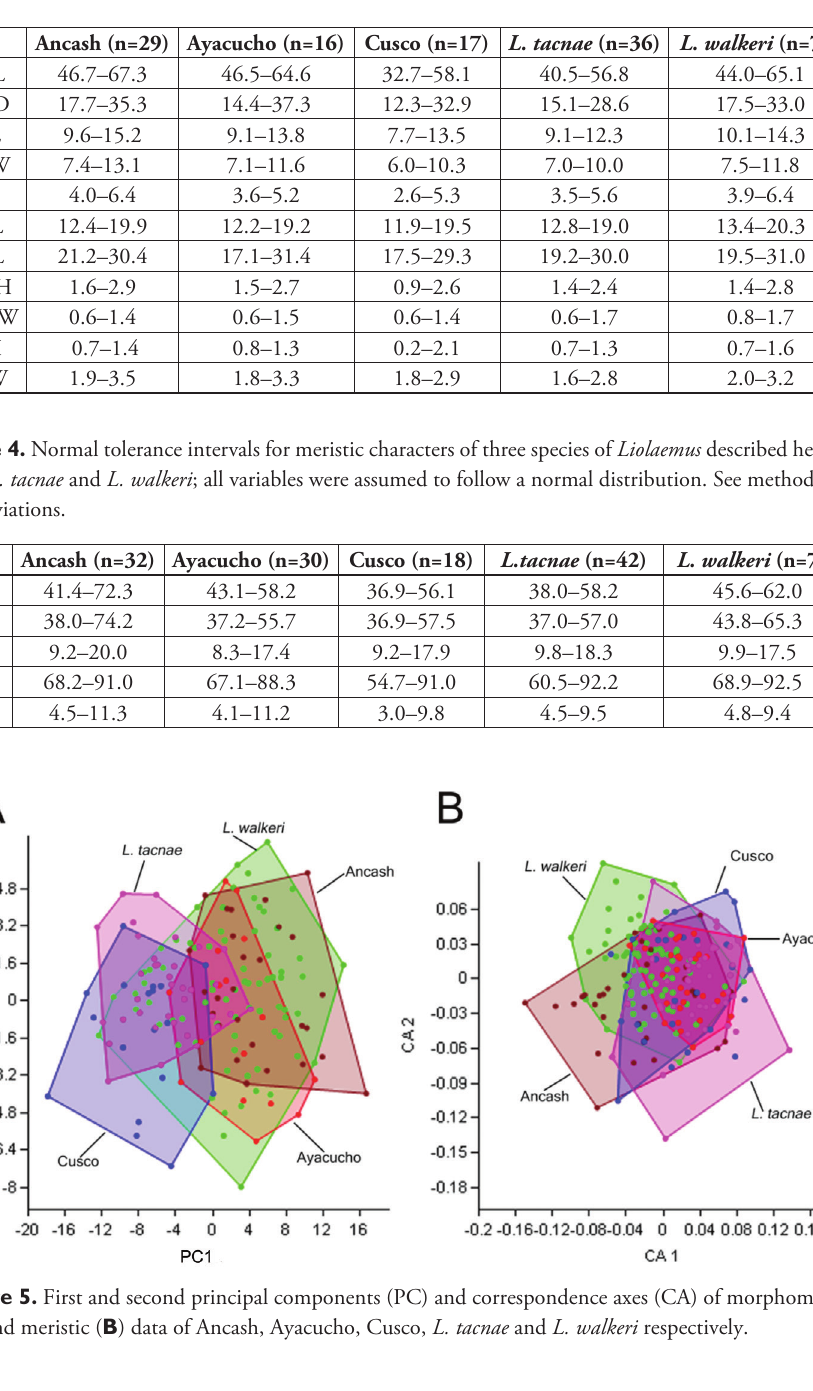
table 3. Normal tolerance intervals for morphometric variables of three species of Liolaemus described herein, plus L. tacnae and L. walkeri ; those identified with an asterisk were assumed to follow a normal distribution. See methods for abbreviations.